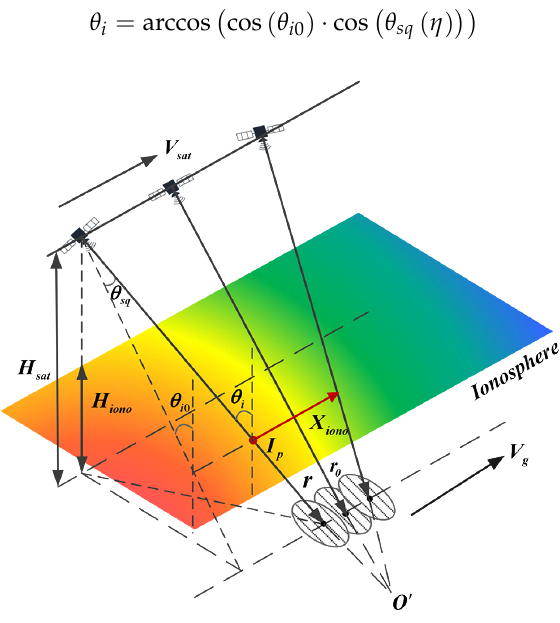
Figure 1. The observation geometry of sliding spotlight SAR with